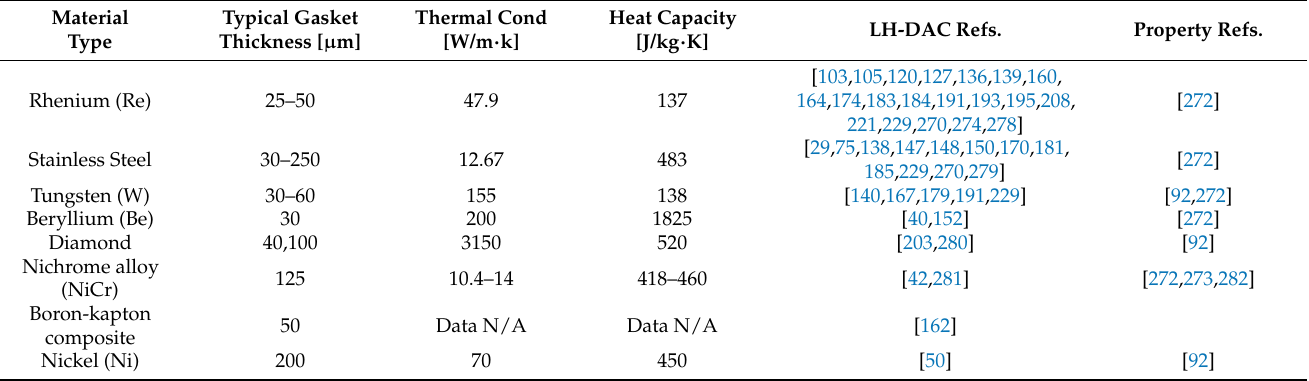
Table 2. Physical properties of common LH-DAC gasket materials, with their reported thickness, compressive strengths, and thermal conductivities at around room temperature ± 100